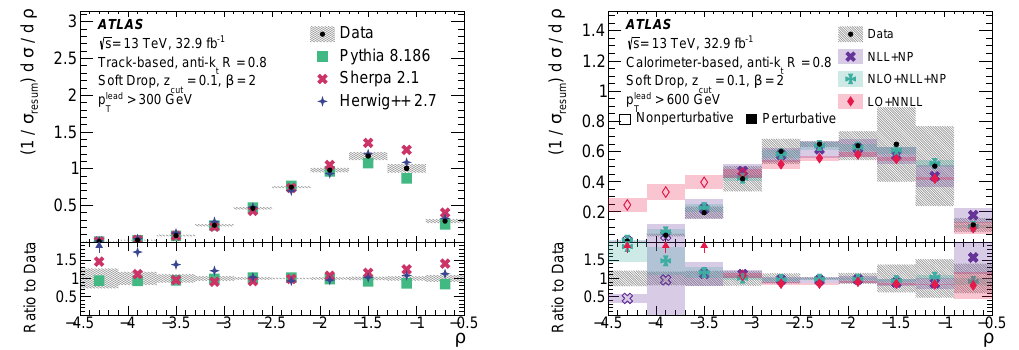
Figure 2: Distribution of the dimensionless mass parameter ρ for events with > 300 GeV (left), compared to MC predictions by P YTHIA , S HERPA and H ER - p lead T > 600 GeV (right) compared to ana- WIG ++ . Distribution of ρ for events with p lead T lytical predictions. Jets entering both distributions are groomed using the soft-drop algorithm with β = 2 [ 2 ]